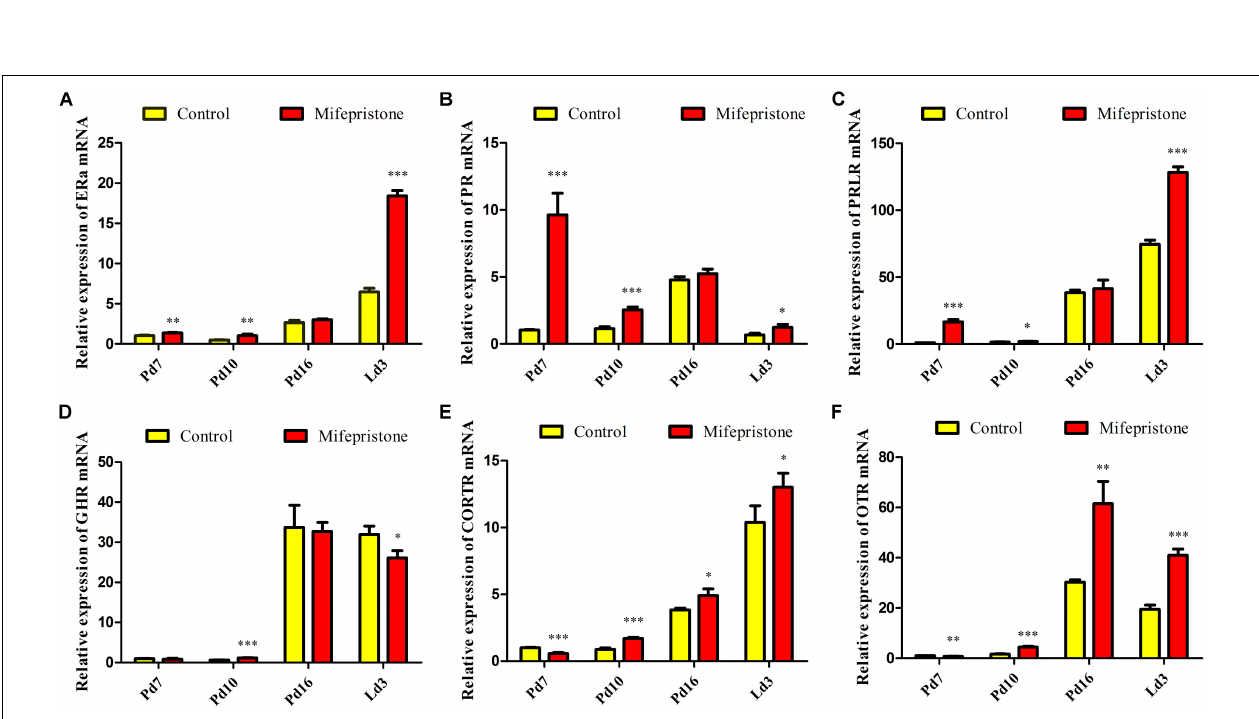
FIGURE 6 | Effect of mifepristone treatment on pregnancy day 4 (Pd4) on mammary mRNA expression of hormone receptors on Pd7, Pd10, Pd16, and lactation day 3 (Ld3). (A) ER α mRNA expression. (B) PR mRNA expression. (C) PRLR mRNA expression. (D) GHR mRNA expression. (E) CORTR mRNA expression. (F) OTR mRNA expression. These experiments were repeated at least three times. Data are represented as means ± SD, ∗ indicates the difference between mifepristone group and control group, ∗ P < 0.05, ∗∗ P < 0.01, ∗∗∗ P < 0.001.